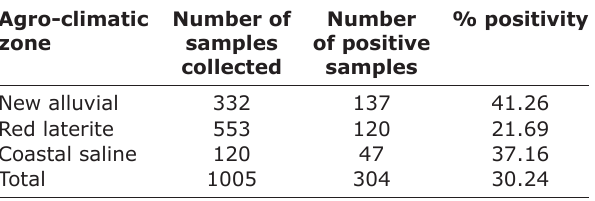
Table-3: Assessment of goat serum samples by i-ELISA to detect anti-bluetongue antibodies. Agro-climatic